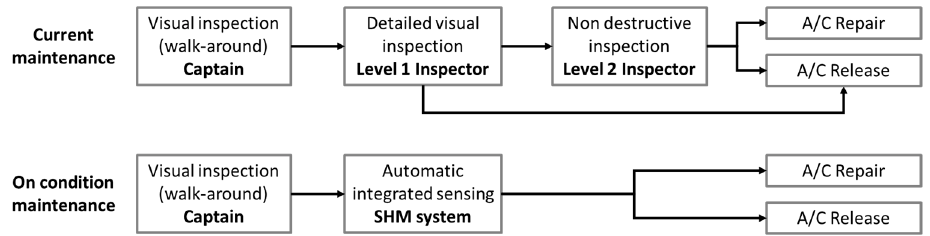
Figure 35. Possible maintenance approaches suited for aircraft operators.